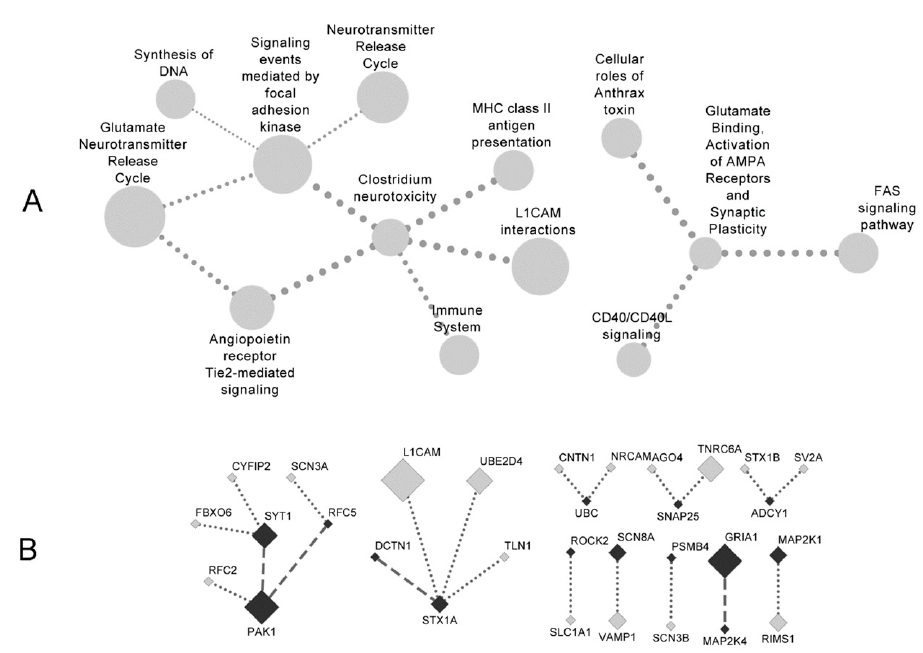
Figure 4. Schizophrenia-specific disrupted pathway crosstalk network ( A ) and accountable correlation-loss gene links ( B ). In ( A ), node size is proportional to the differential co-expression p -value (aggregated from five datasets), and edge width is proportional to (disrupted) pathway connection p -value. In ( B ), node size is proportional to the multiplicity of genes’ pathway membership; black and gray nodes denote differentiate pivotal genes and other genes, respectively; dashed lines connect pivotal genes on both ends, and dotted lines connect pivotal genes on single ends.